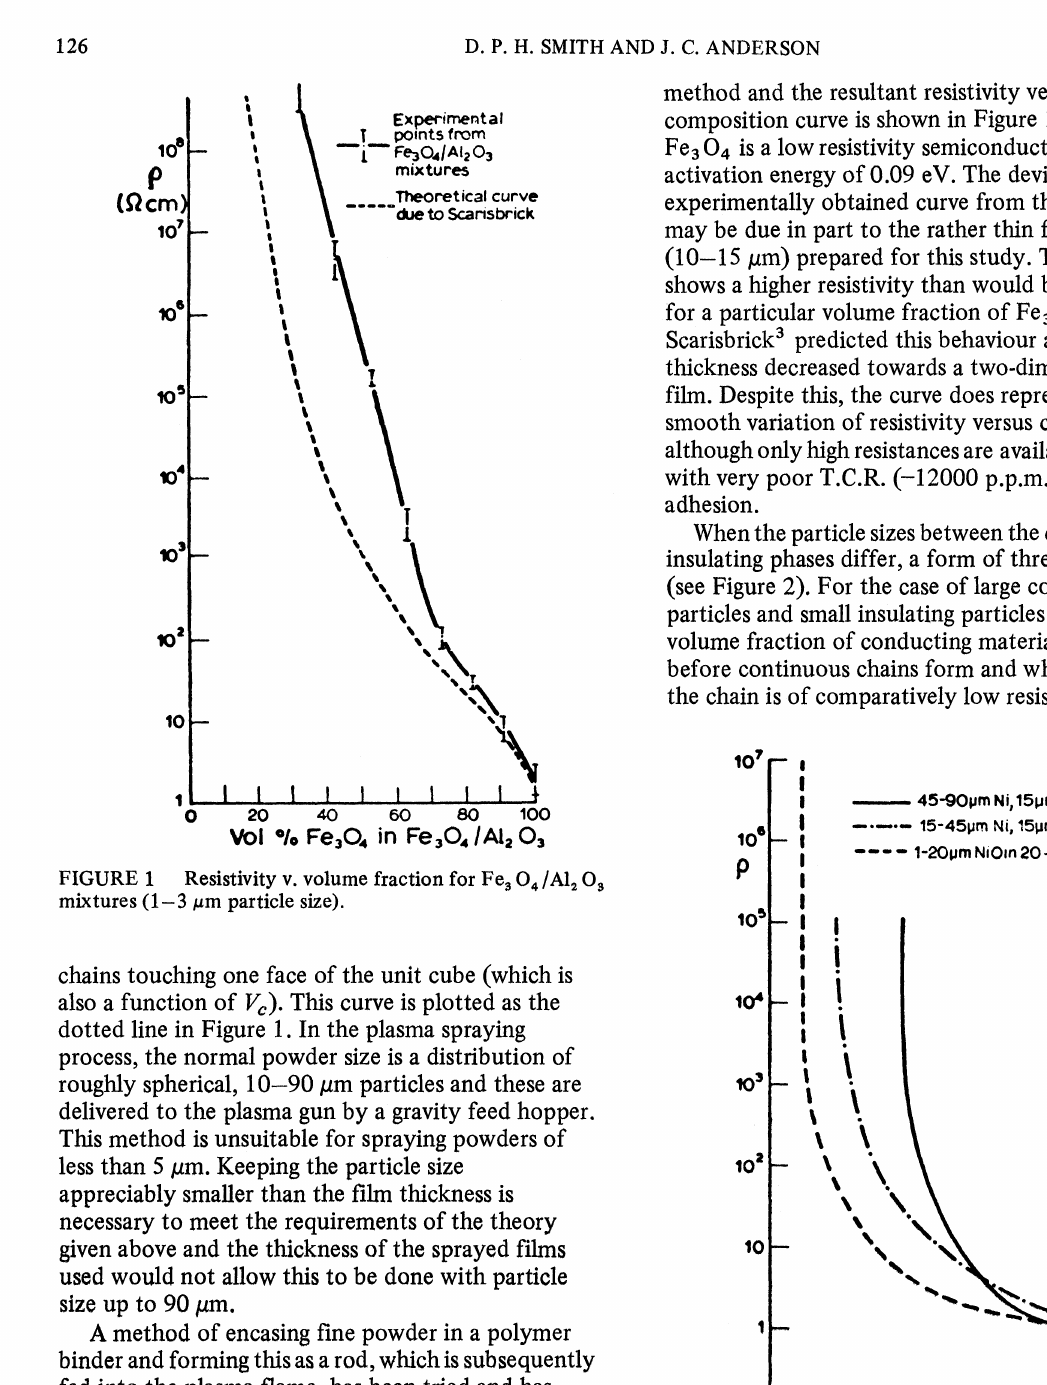
Resistivity v. volume fraction for metal/insulator mixtures of unequal particle